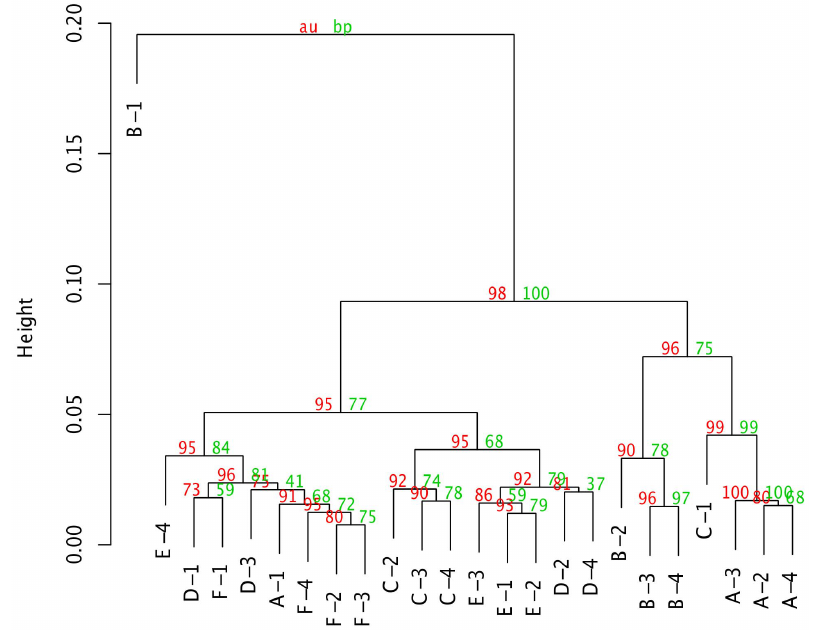
Figure 5. Example of a dendrogram with bootstrap values using PIIKA 2. The clustering of the samples is the same as in Figure 1. The red numbers represent the approximately unbiased (AU) P-values as determined using the method of Shimodaira [17,18], while the green numbers represent the standard bootstrap P-value [16]. All calculations and the drawing of the figure were performed using the R package pvclust [19].